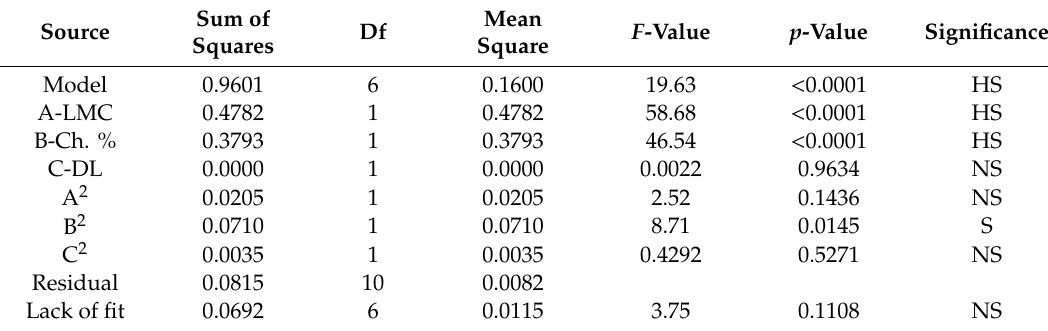
Table 4. Analysis of variance for the poly dispersity index (PDI) of the developed